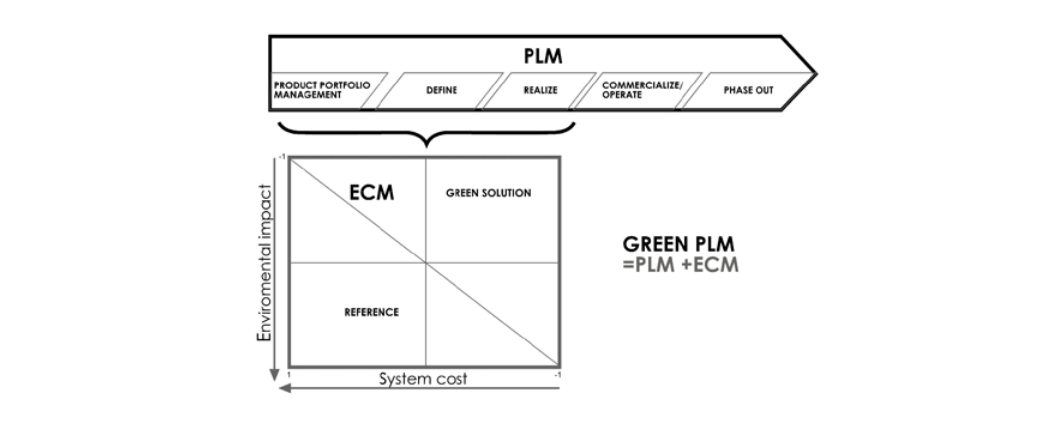
Figure 4. “Eco Care